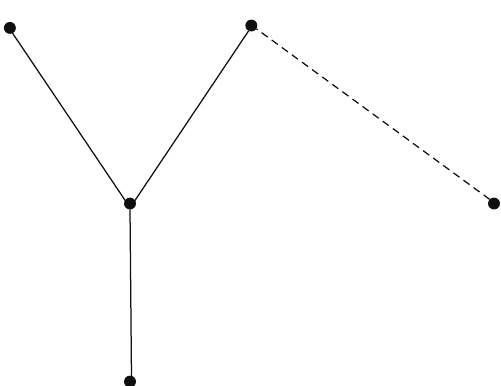
Figure 4: Decomposition of Steiner